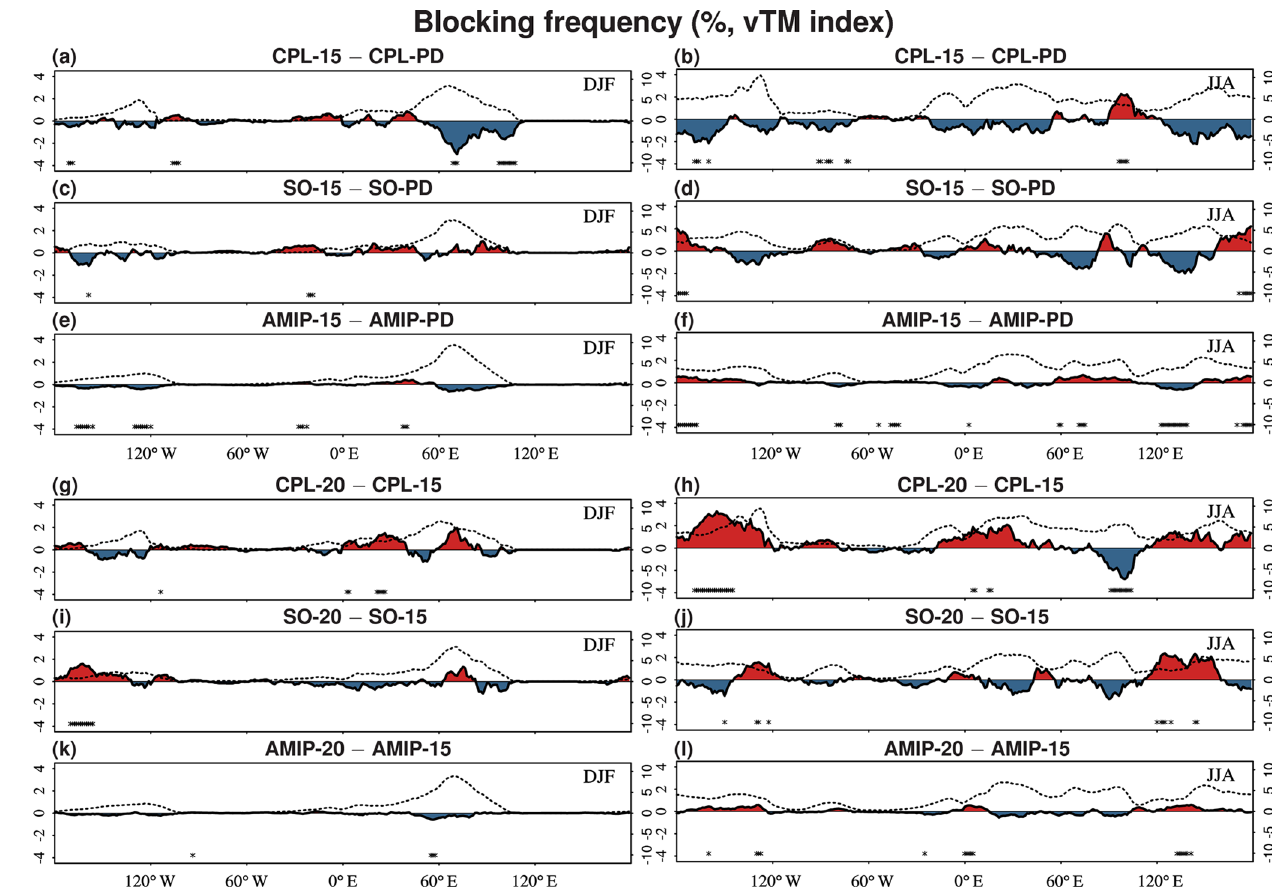
Figure 18. Change in blocking frequency (solid black line with red and blue shading) in the 1.5 ◦ C experiment relative to PD (a–f) and for the additional 0.5 ◦ C of warming (2.0–1.5 ◦ C; g–l ), shown along with the blocking climatology for the PD experiment (dotted black line). The fields are shown for NorESM1-Happi (a, b, g, h) , NorESM1-HappiSO (c, d, i, j) , and NorESM1-HappiAMIP (e, f, k, l) during DJF (a, c, e, g, i, k) and JJA (b, d, f, h, j, l) for the default periods given in Sect. 3. The asterisks along the x axis indicate where the changes at that longitude are statistically significant at the 5% level according to the Welch t test. Note that the left y axis is for the difference field and the right y axis is for the climatology. Units are percentages (a–l)